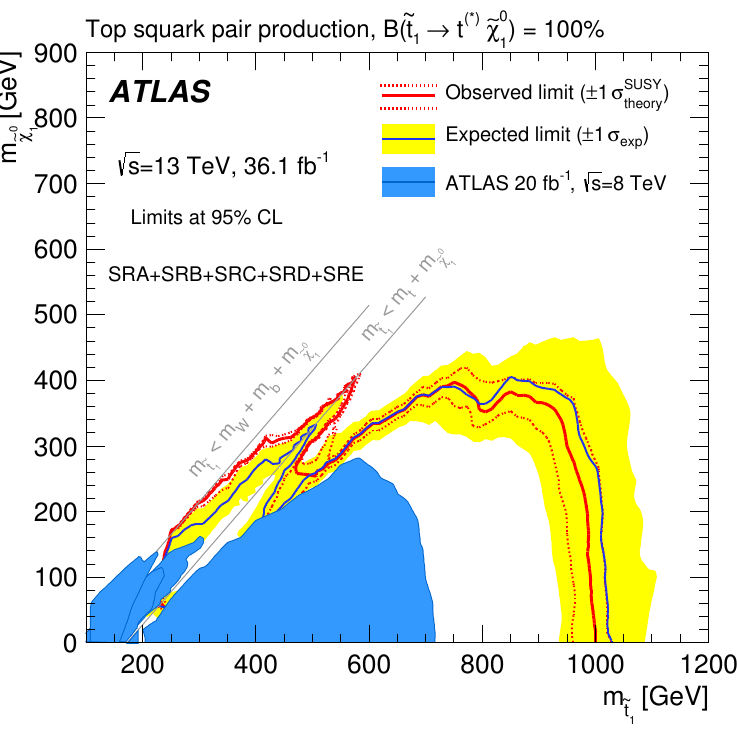
Figure 8. Observed (red solid line) and expected (blue solid line) exclusion contours at 95% CL as a function of ~ t 1 and ~ (cid:31) 0 1 masses in the scenario where both top squarks decay via ~ t 1 ! t ( (cid:3) ) ~ (cid:31) 0 1 . Masses that are within the contours are excluded. Uncertainty bands corresponding to the (cid:6) 1 (cid:27) variation of the expected limit (yellow band) and the sensitivity of the observed limit to (cid:6) 1 (cid:27) variations of the signal theoretical uncertainties (red dotted lines) are also indicated. Observed limits from all p third-generation Run-1 searches [26] at s = 8 TeV overlaid for comparison in